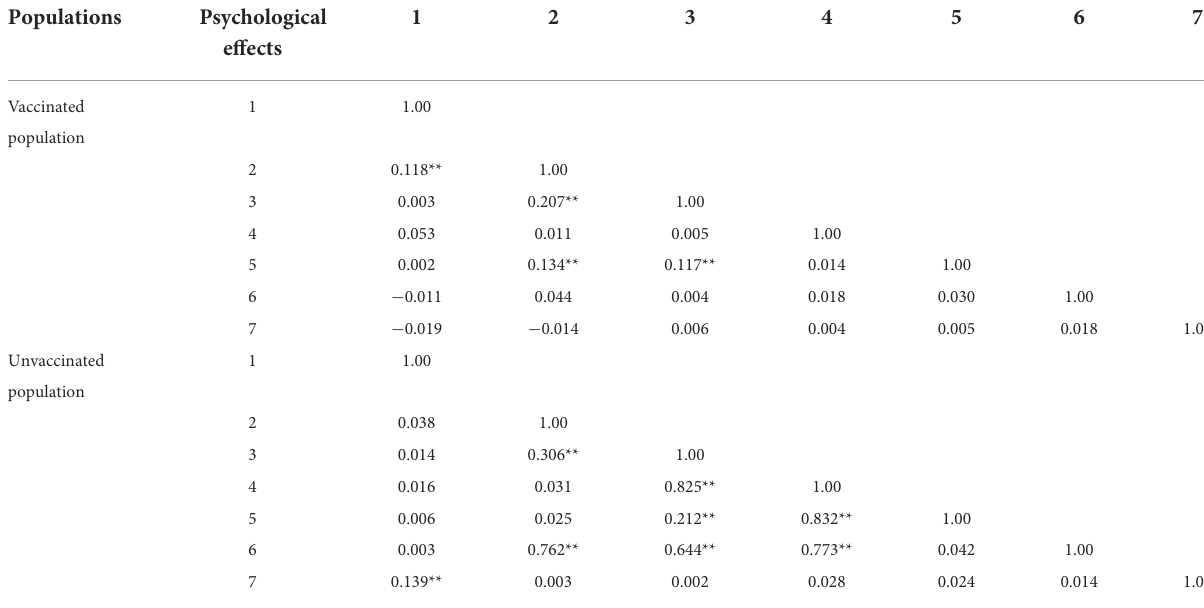
TABLE 4 Spearman’s correlations of psychological effects among vaccinated and unvaccinated populations against COVID-19 infection.